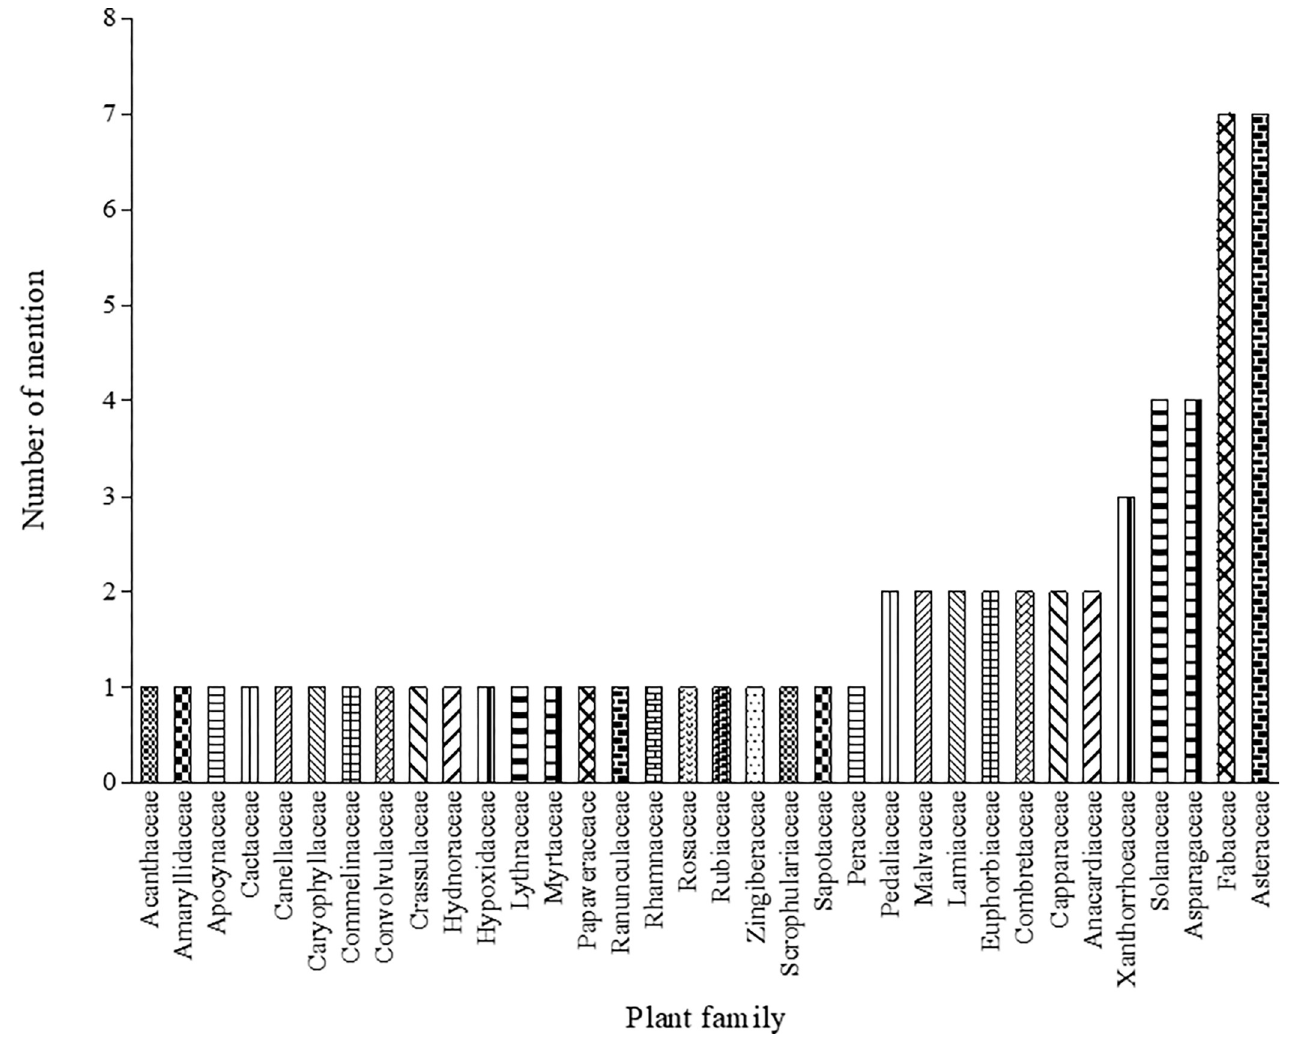
Fig 2. Frequency of plant families used to manage and treat childhood diseases in Ngaka Modiri Molema and Bojanala districts of North West Province, South Africa.